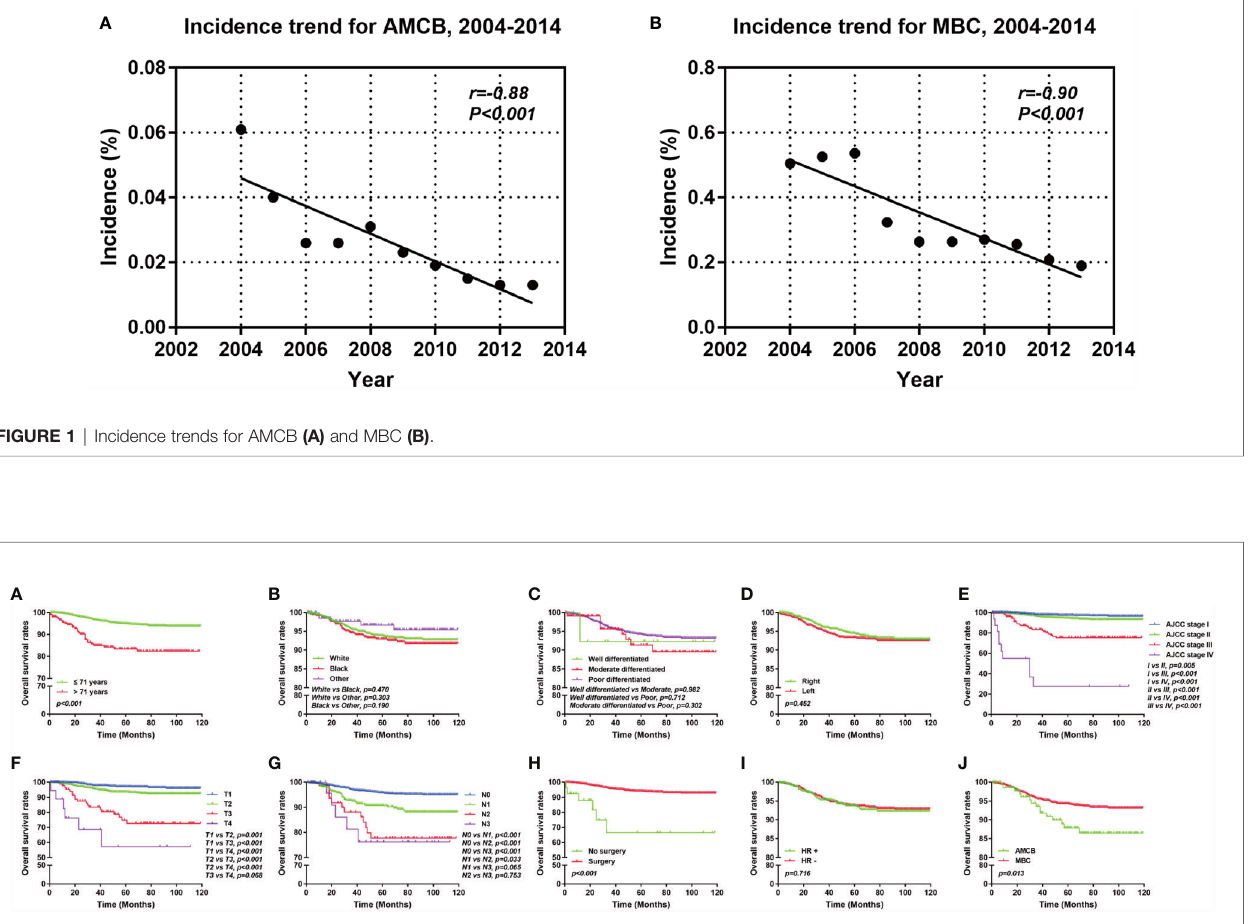
FIGURE 2 | Overall survival of MBC and AMCB patients using the Kaplan – Meier estimator strati fi ed by (A) age at diagnosis; (B) race; (C) grade; (D) laterality; (E) AJCC stage; (F) primary tumour size; (G) lymph node status; (H) surgery for primary tumour; (I) HR status; and (J) histological type.